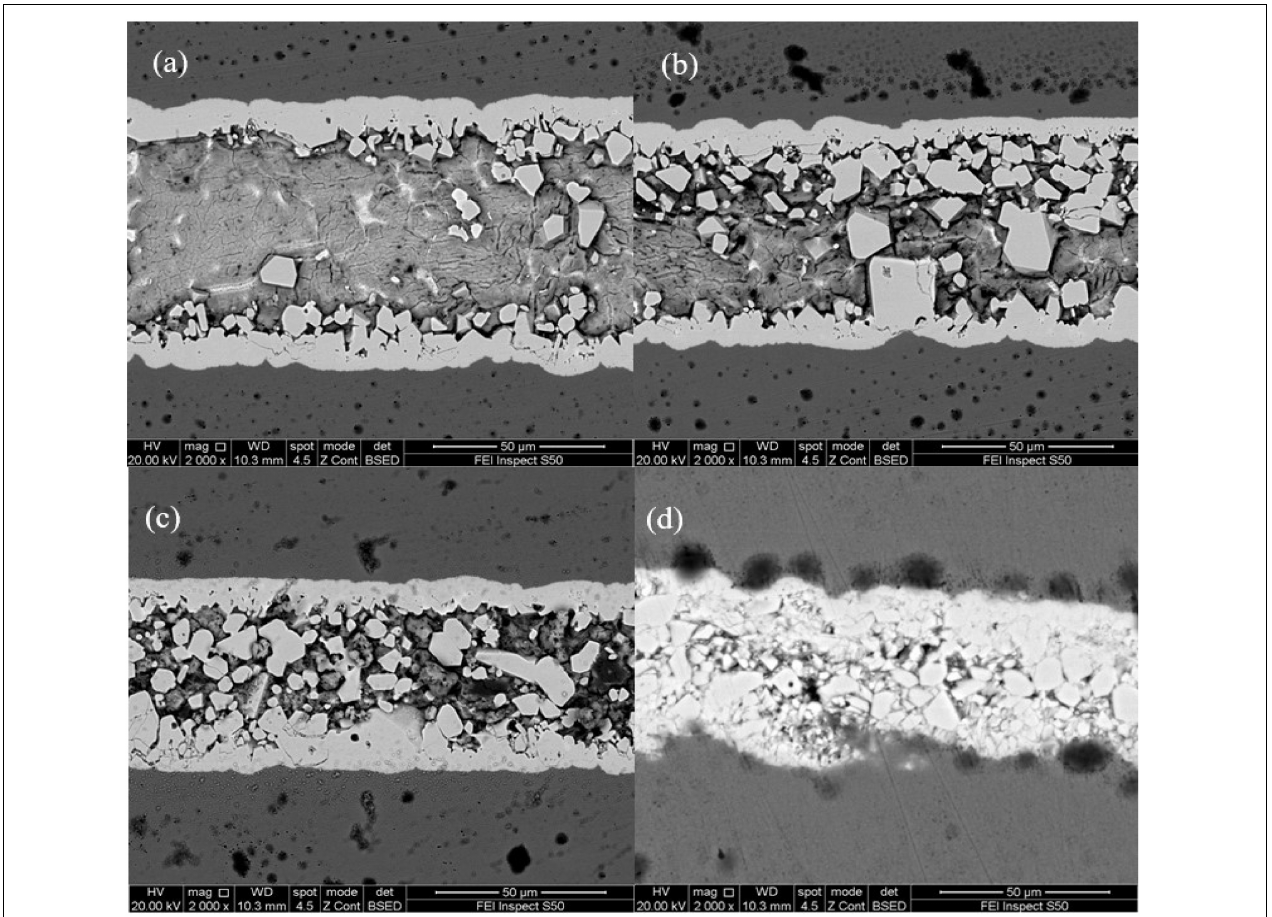
FIGURE 1 | Solder joints with different bonding time: (a) 10 min, (b) 15 min, (c) 40 min, and (d) 180